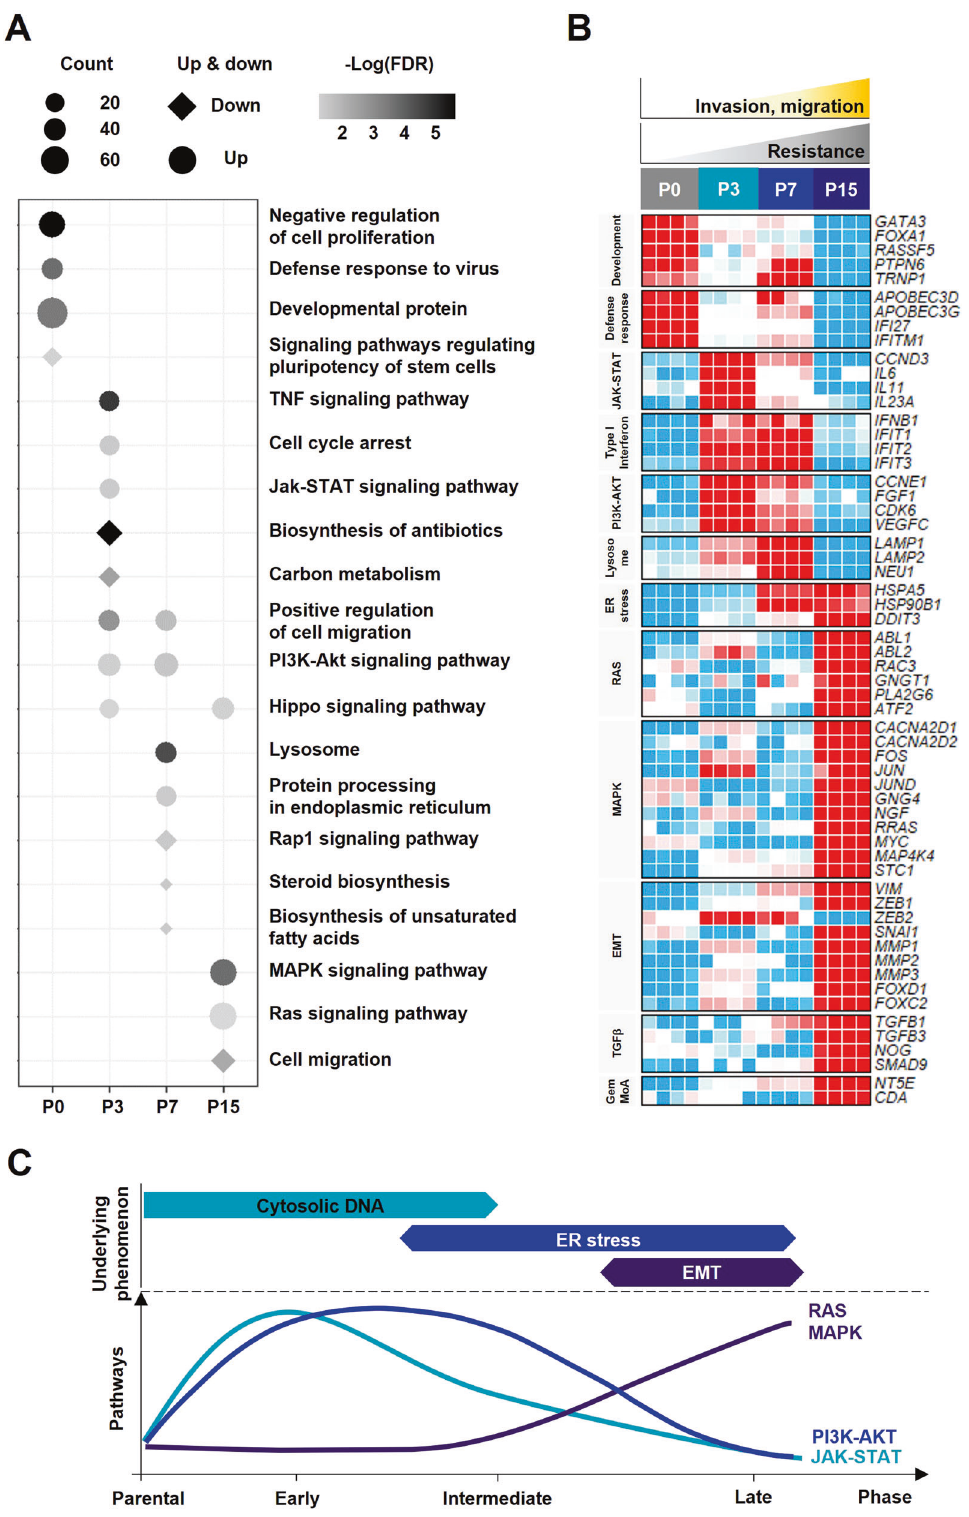
Fig. 4 Signi fi cant biological characteristics and gene expression patterns representing four time-points. A Biological characteristics at each time-point. The size of the symbol indicates the number of genes on each term. The diamond and circle shapes indicated downregulation and upregulation, respectively. The darkness indicates the degree of FDR. B Gene expression patterns associated with signi fi cantly identi fi ed biological characteristics at each time-point. The colors in the heatmap re fl ect relatively high (red) and low (blue) expression CPM values. C Schematic graph of molecular changes in gemcitabine resistance. The top indicates the underlying phenomenon related to gemcitabine resistance. The bottom panel shows a graph of the signaling pathways that induce gemcitabine resistance. FDR false discovery rate, ER endoplasmic reticulum, EMT epithelial to mesenchymal transition, MoA mechanism of action.